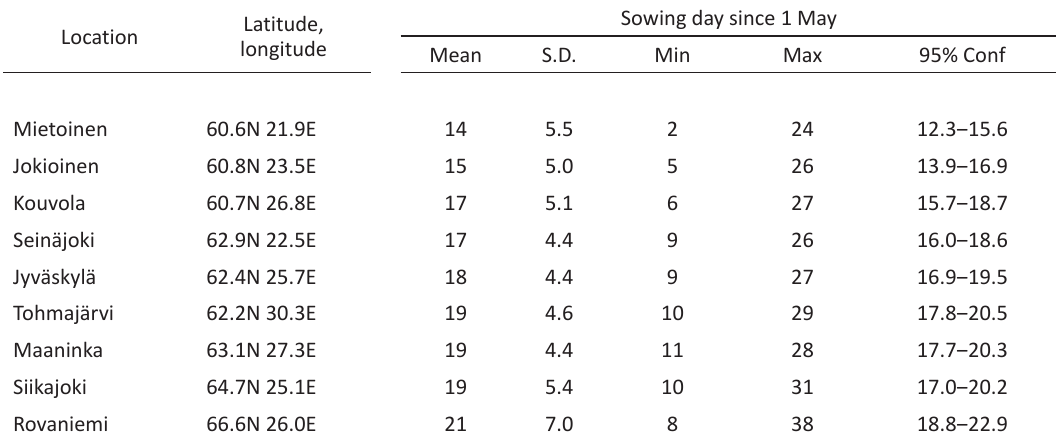
Table 2. Variation in the onset of spring sowings on a large scale at nine locations in Finland. Data for 1970‒2012 (Peltonen- Sainio and Jauhiainen 2014). SD (standard deviation); 95% Conf (95 % confidence) limits of the